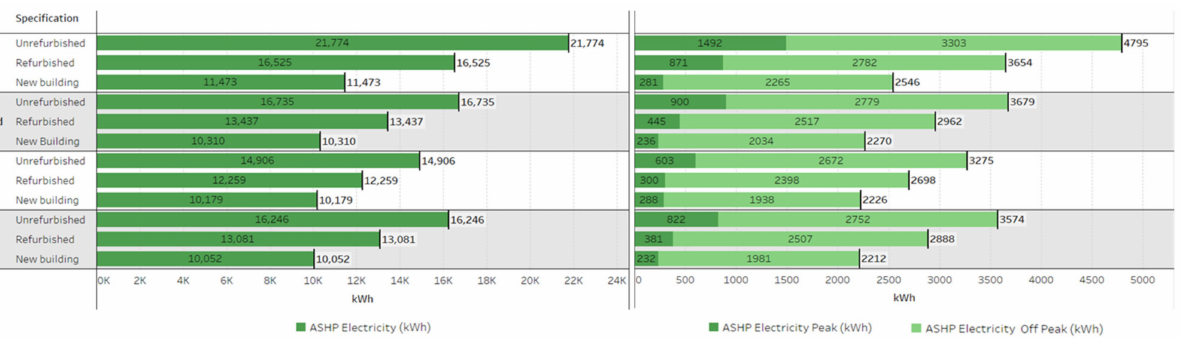
Figure 8. Energy demand results ( left ) and proposed energy supply ( right ) by house archetypes for heat pump uptake